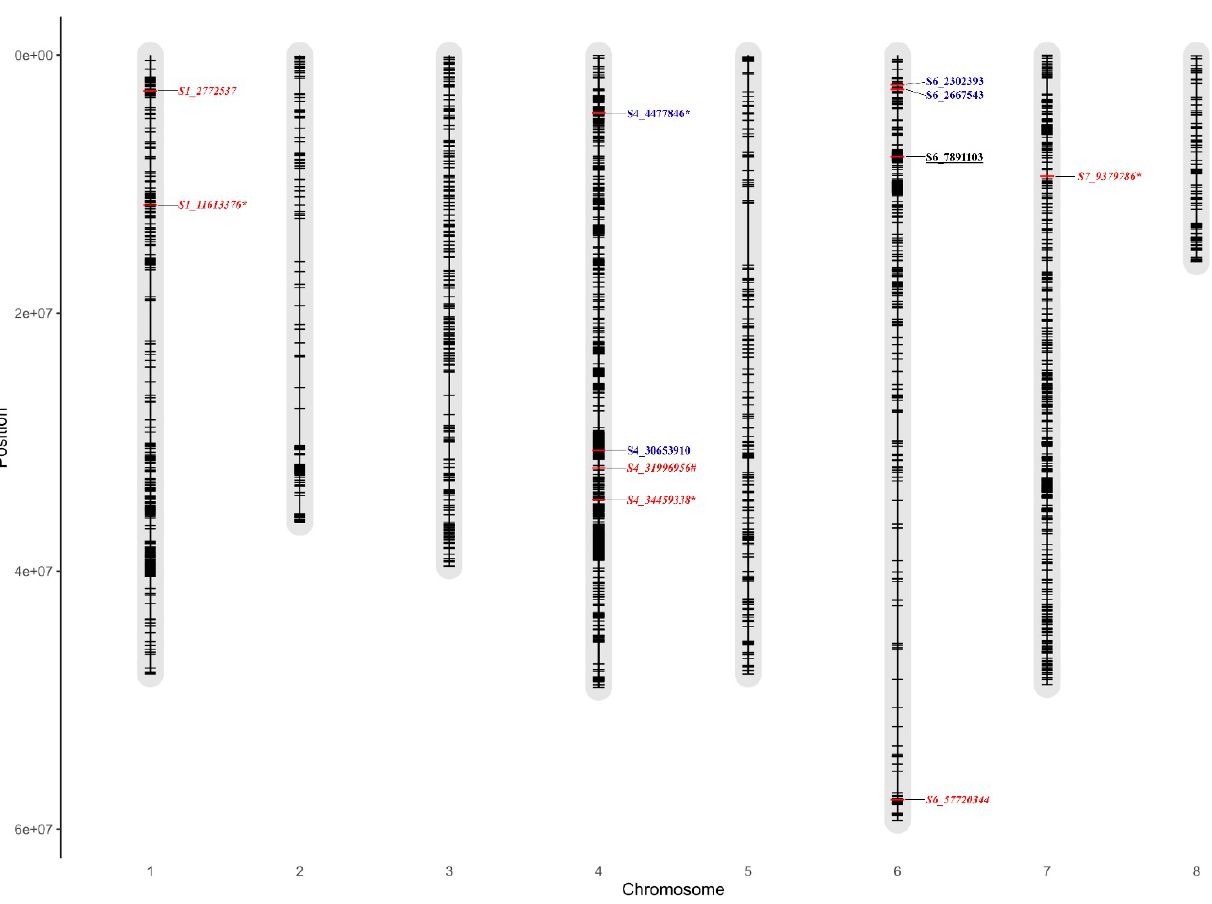
Figure 6. Visualization of significantly associated SNPs (MTAs) along with co-associated SNPs (*) over the seasons on chickpea chromosomes for grain protein (blue, Bold), Fe (red, Bold Italic ), Zn (black, Bold underline). # Co-associated markers grain Fe and DM. Fe, grain iron content; Zn, grain zinc content.